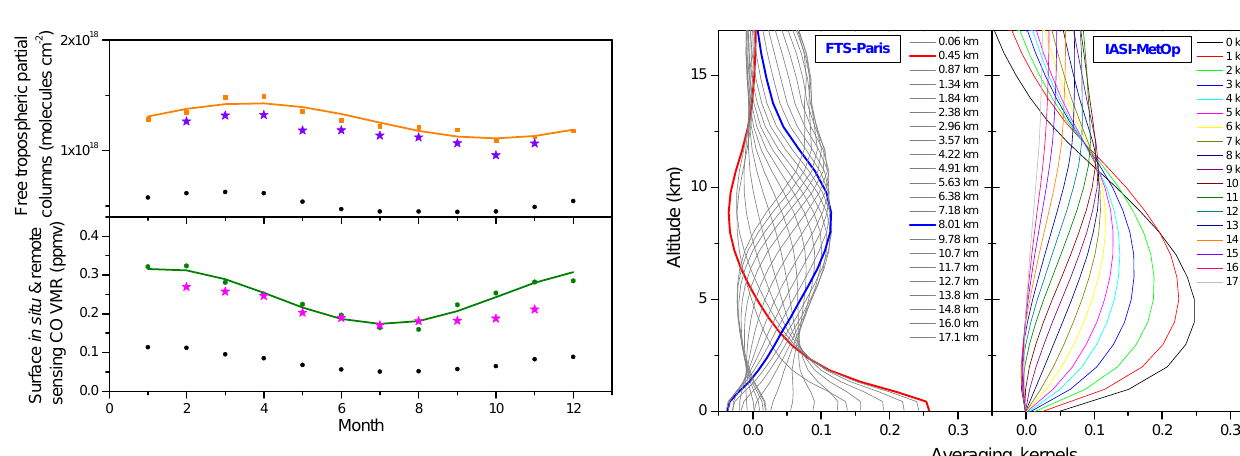
Figure 4. Free tropospheric (top) and surface (bottom) CO at Paris as monthly averages over 5 years. CO VMR in the PBL comes from the in situ CO analyser (dark green hexagons) and the FTS-Paris (magenta stars), as well as from the GEOS-Chem model (black circles). Free tropospheric CO columns were calculated between 2 and 12km and monthly averaged over the period from 2009 to 2013. Shown are data from IASI–MetOp (orange squares), FTS- Paris (purple stars) and GEOS-Chem modelling (black circles). A sine function fit is applied to the IASI–MetOp (orange line) and in situ CO data (dark green line).